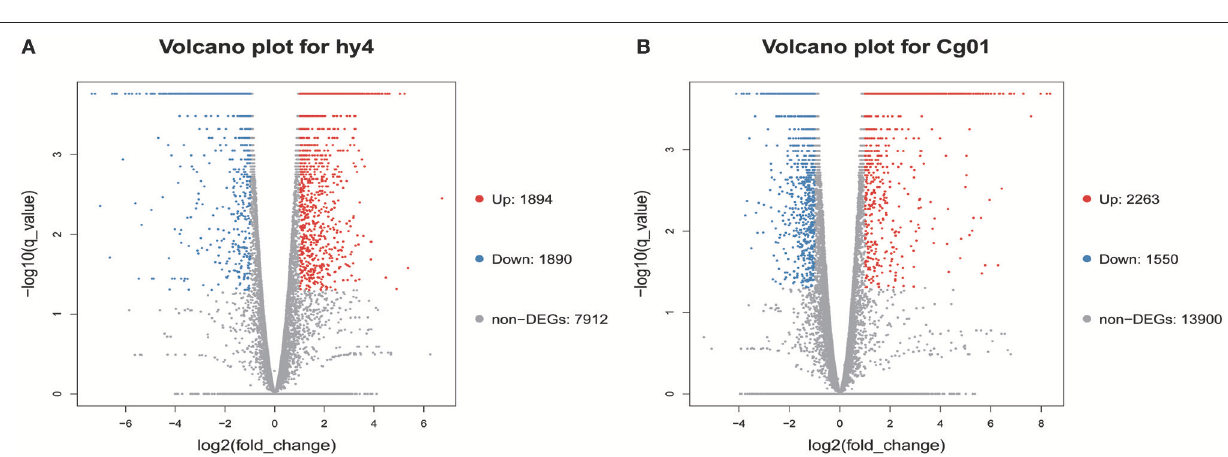
“Tryptophan metabolism,” “Methionine metabolism,” and “Glutamate metabolism” ( Figure 6